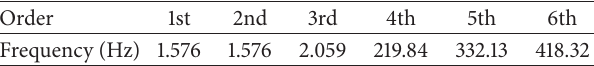
Table 2: Natural frequencies of the centrifuge. Order 1st 2nd 3rd 4th 5th 6th Frequency (Hz) 1.576 1.576 2.059